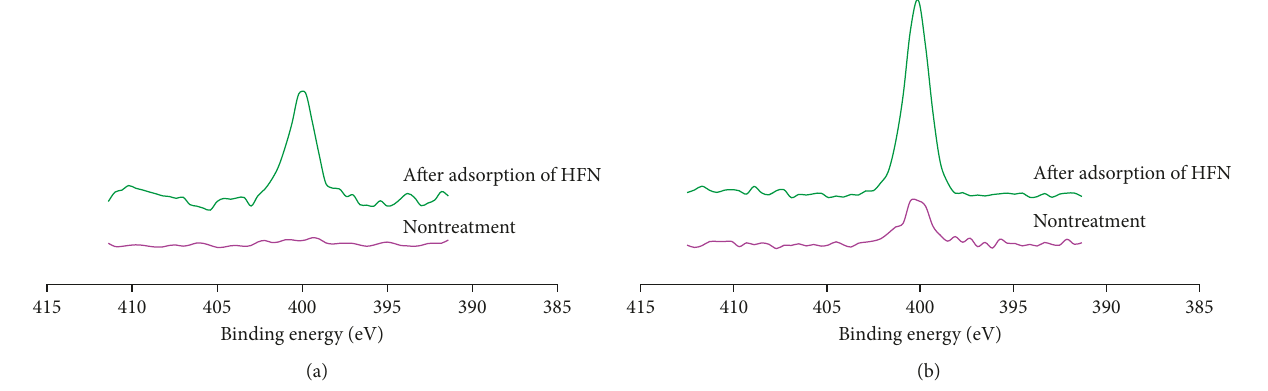
Figure 9: N1s XPS spectra of (a) Ti and (b) TNS QCM sensors after immersion in HFN.